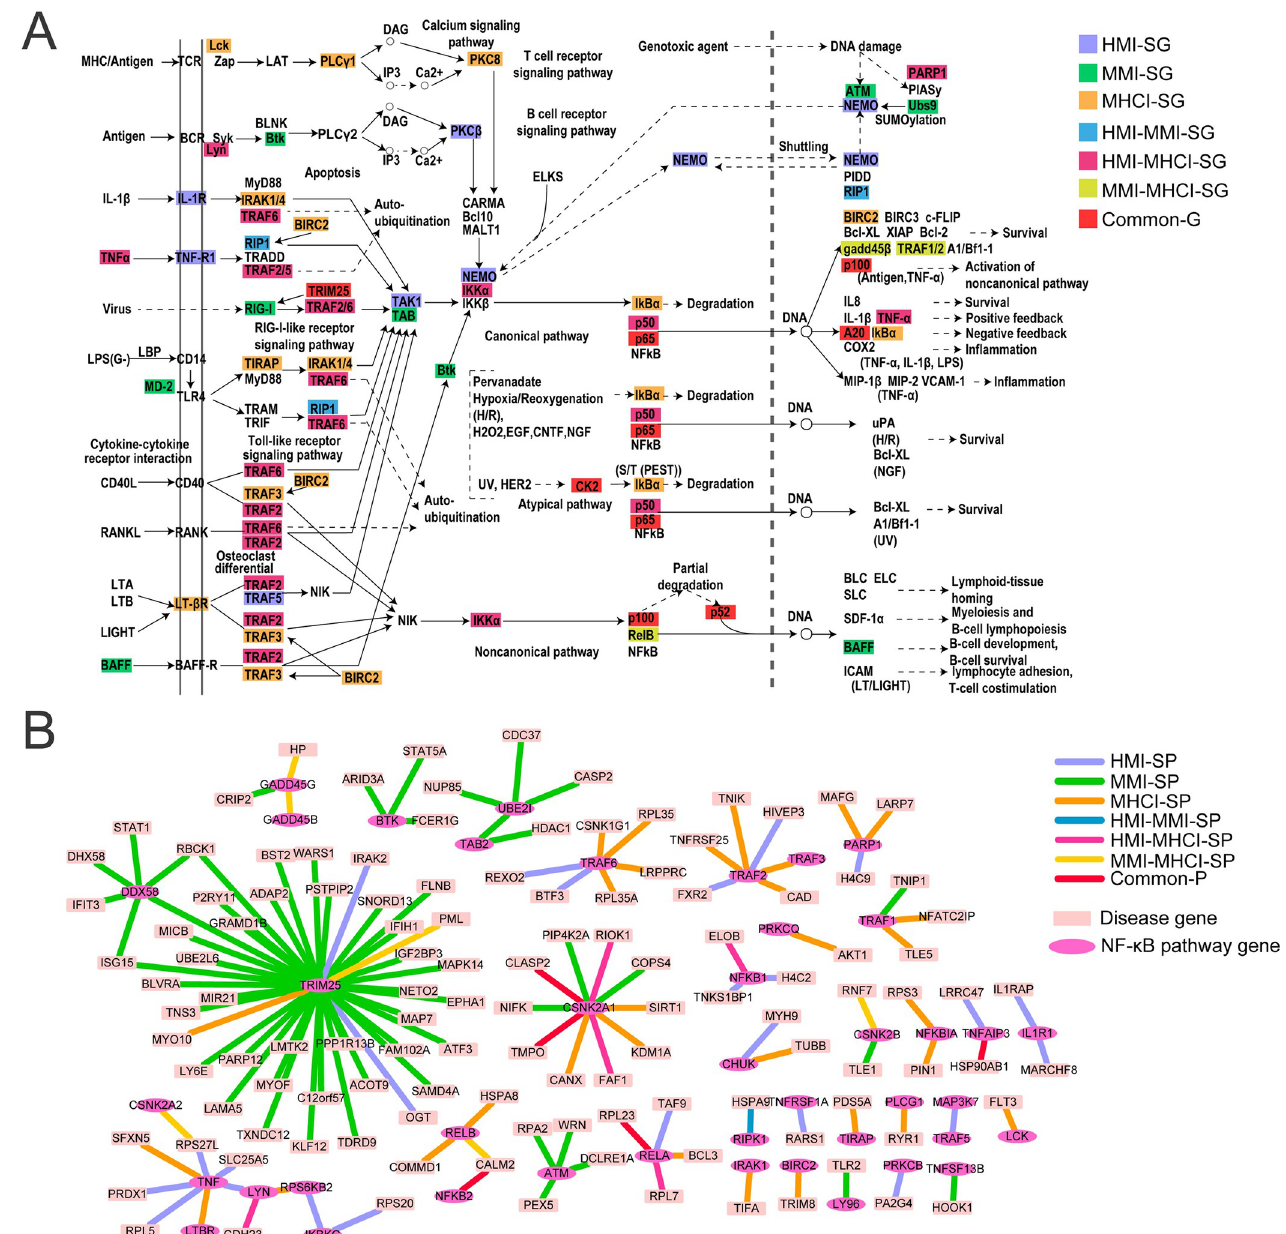
Fig 8. Disease-related genes and gene pairs in NF- κ B signaling pathway. (A) Disease-related genes. (B) Disease-related gene pairs.